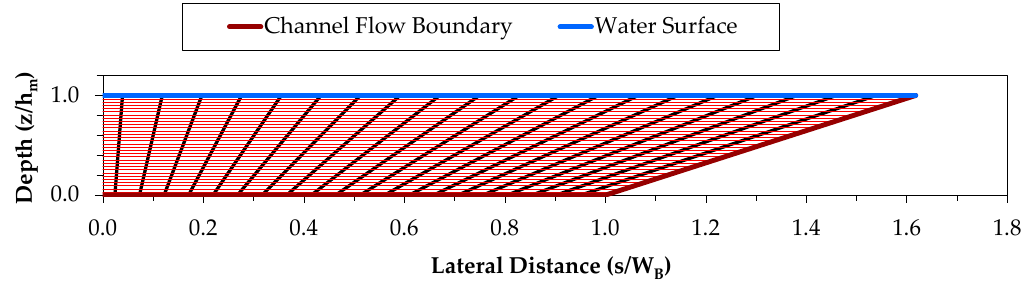
Figure 26. Concept of the 3D structured mesh is presented for the right half of the cross section. A color contour shading of surface velocities from the 3D model results is presented in Figure 27. A close-up view of cross-sectional slices of velocity magnitude through a meander bend is presented in Figure 28. Water 2020 , 12 , x FOR PEER REVIEW